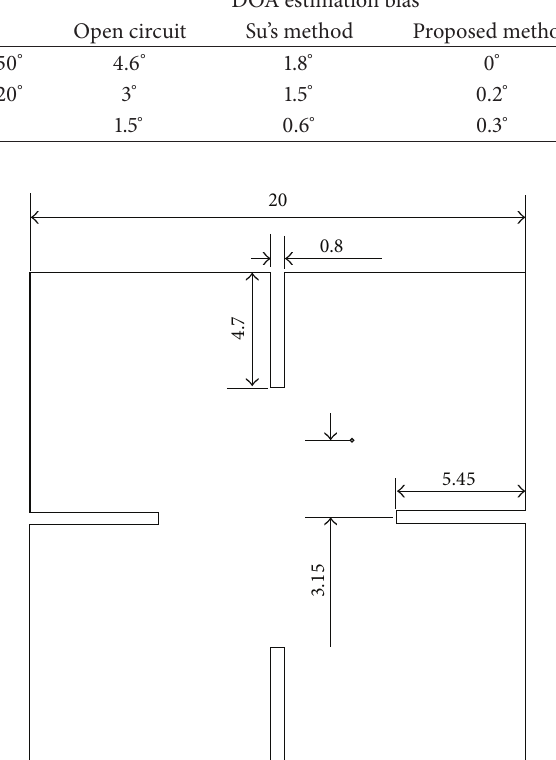
Figure 4: Profile of the circularly polarized microstrip element with the unit mm.